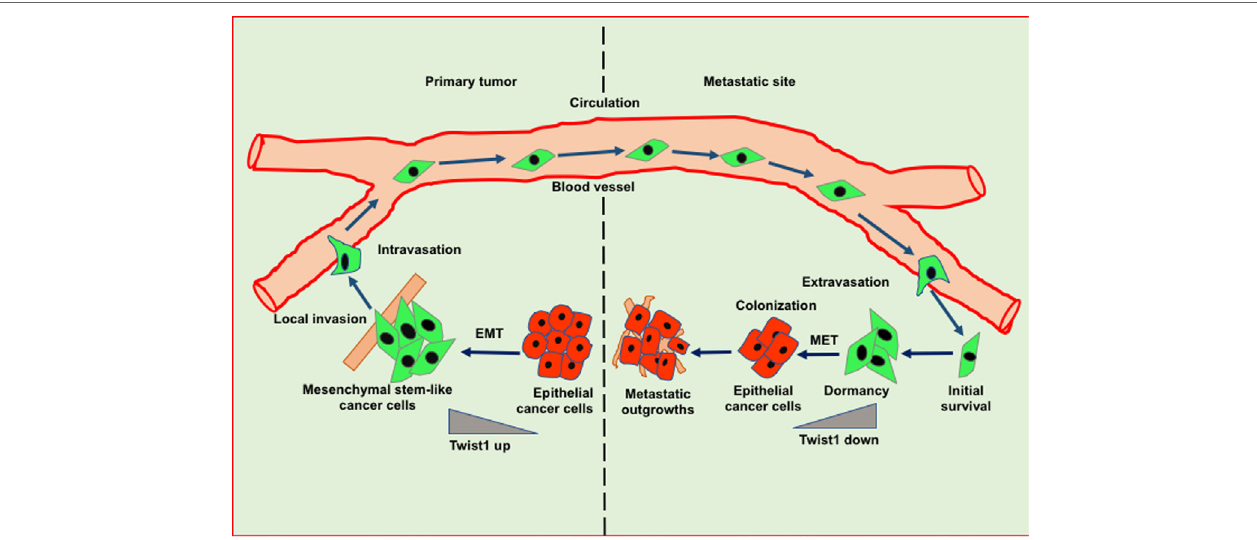
FiGURe 2 | Role of epithelial to mesenchymal transition (EMT) and mesenchymal to epithelial transition (MET) in invasion-metastasis cascade. Cancer cells undergo EMT to acquire stemness and invasion potential leading to cancer cell dissemination. In the target organ, disseminated cancer cells encounter inhibitory signals resulted in the arrest in cell cycle thereby leading to dormancy. Cancer cells undergo MET in order to acquire epithelial features such as proliferation to form metastatic outgrowth in the target